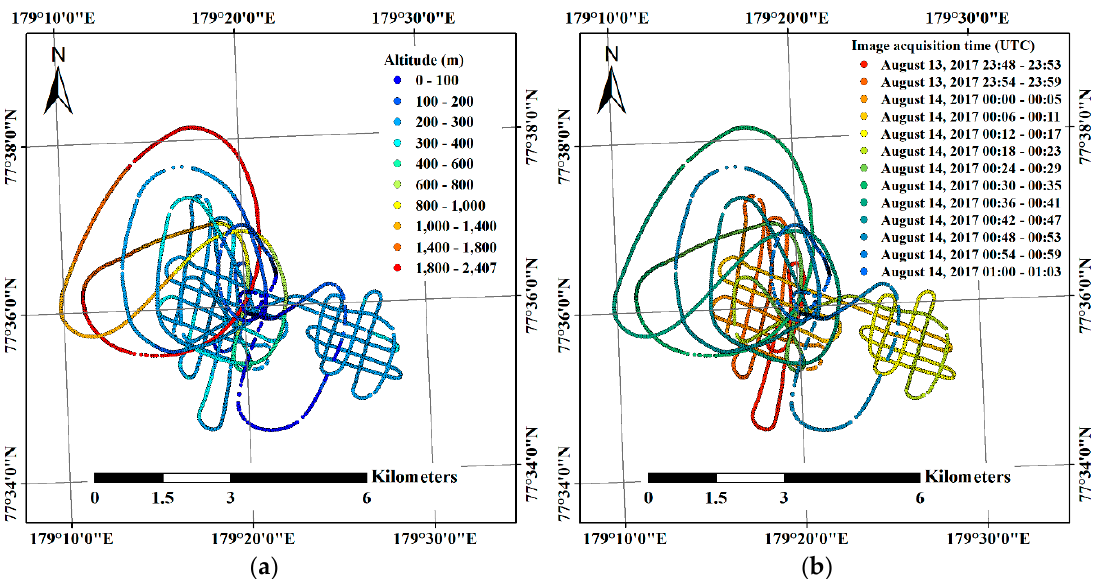
Figure 3. Helicopter-borne VHR image acquisition results: ( a ) locations and altitudes of image acquisition; and ( b ) corresponding image acquisition date and time, expressed as hh:mm. Table 4. Details for image subsets selected from helicopter-borne VHR images.